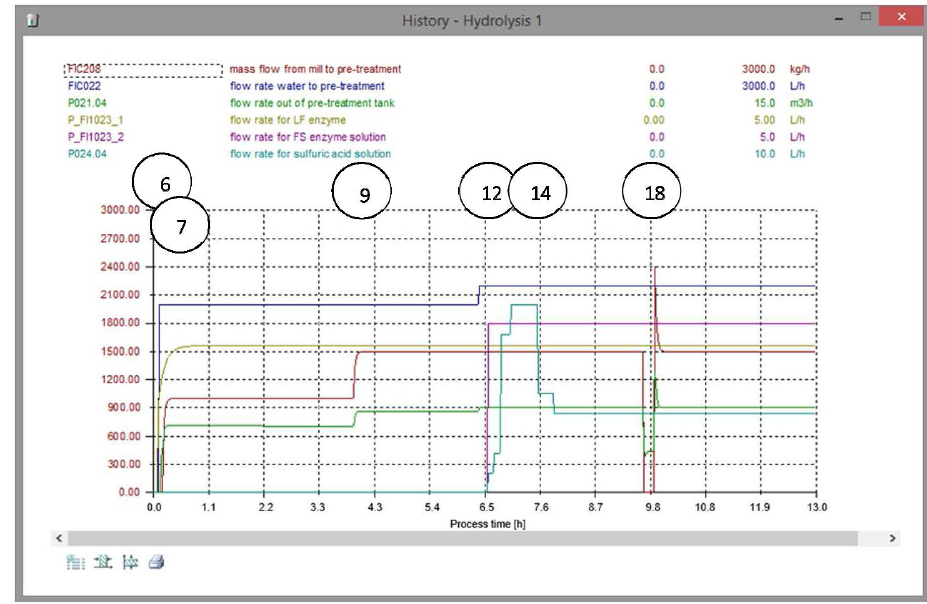
Figure 8. On-line signals from the start-up procedure (shown for 13 h). It shows the adjustment of flow rates. Via the sub-window shown on the GUI in Figures 6 and 7, on-line signals can be selected by pushing the button “ History. ” Numbers indicate the procedural step according to the provided SOP (Table